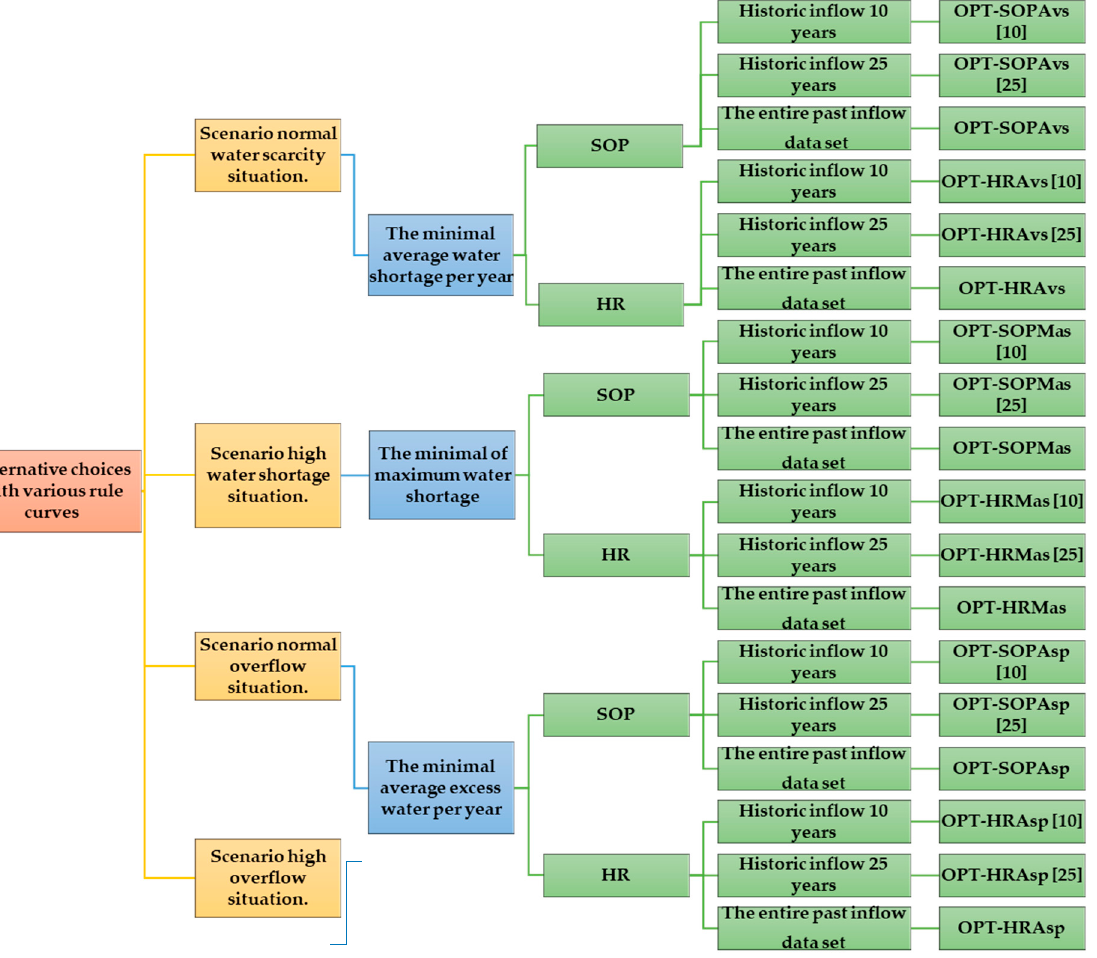
Figure 6. Alternative choices for operating network reservoirs under different rule curve scenarios.